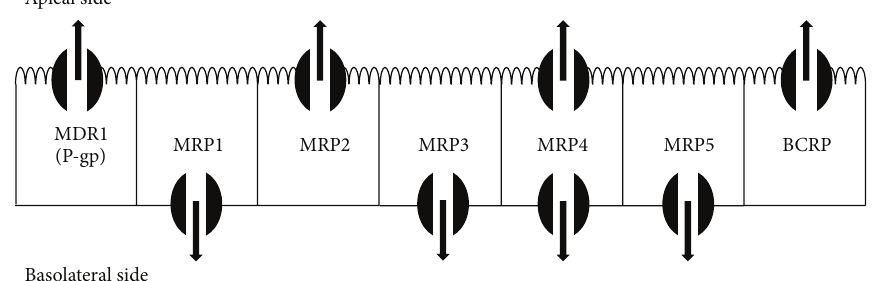
Figure 3: Cellular localization of intestinal ABC transporters (taken and modified from Brand W. et al. Flavonoid-mediated inhibition of intestinal ABC transporters may affect the oral bioavailability of drugs, food-borne toxic compounds, and bioactive ingredients. Biomed Pharmacother. 2006